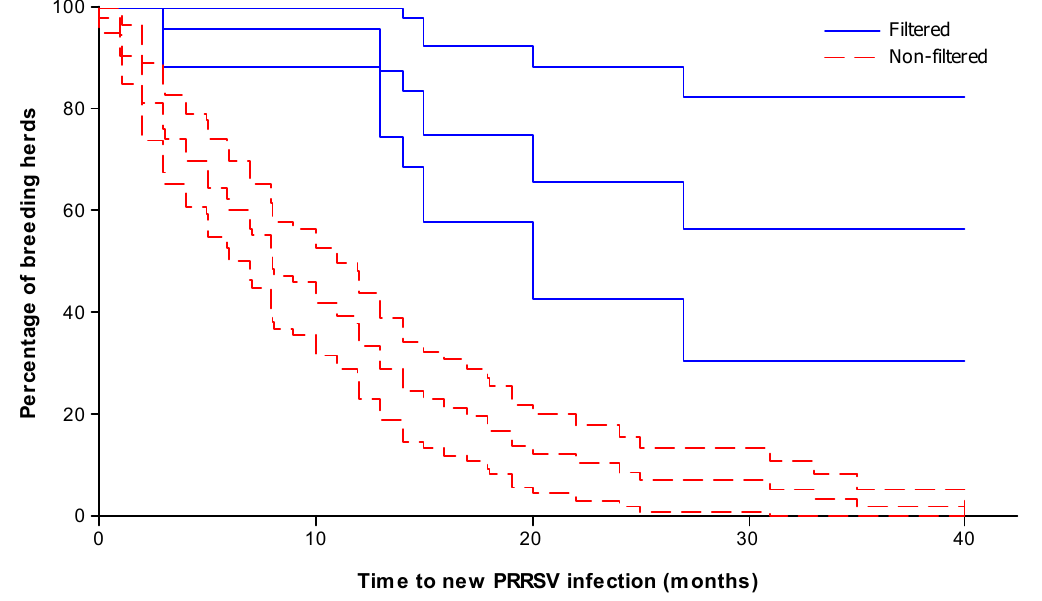
Figure 2. Kaplan-Meier curves for estimated survival functions for filtered and non-filtered herds. Each estimate is accompanied by a point-wise 95% confidence